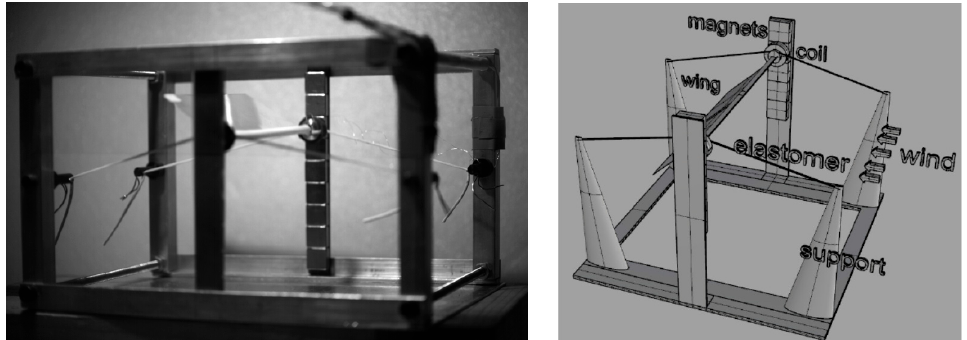
Figure 1. A picture and a schematic representation of a FLEHAP (FLuttering Energy Harvester for Autonomous Powering) device prototype.